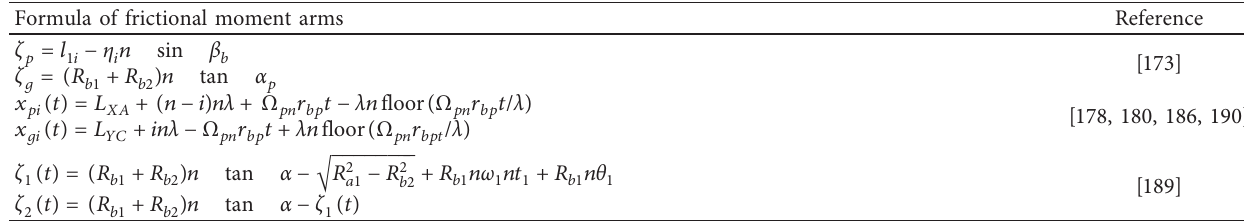
Table 3: Formula of frictional moment